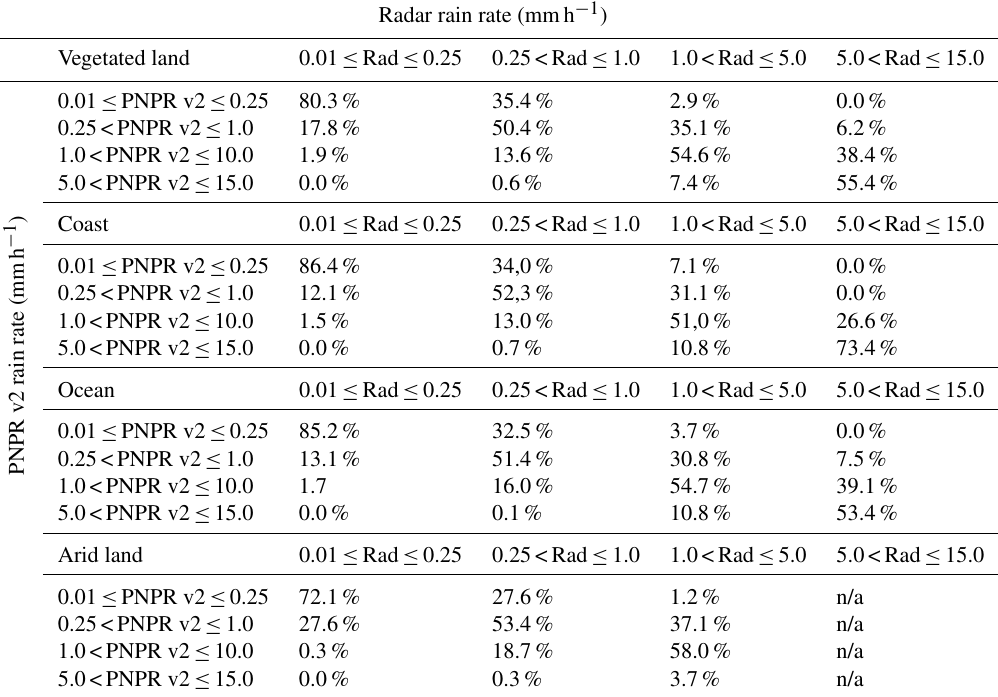
Table 2. Contingency table of PNPR v2 retrievals relative to TRMM-PR measurements (at 0.5 ◦ × 0.5 ◦ resolution). n/a indicates not available.